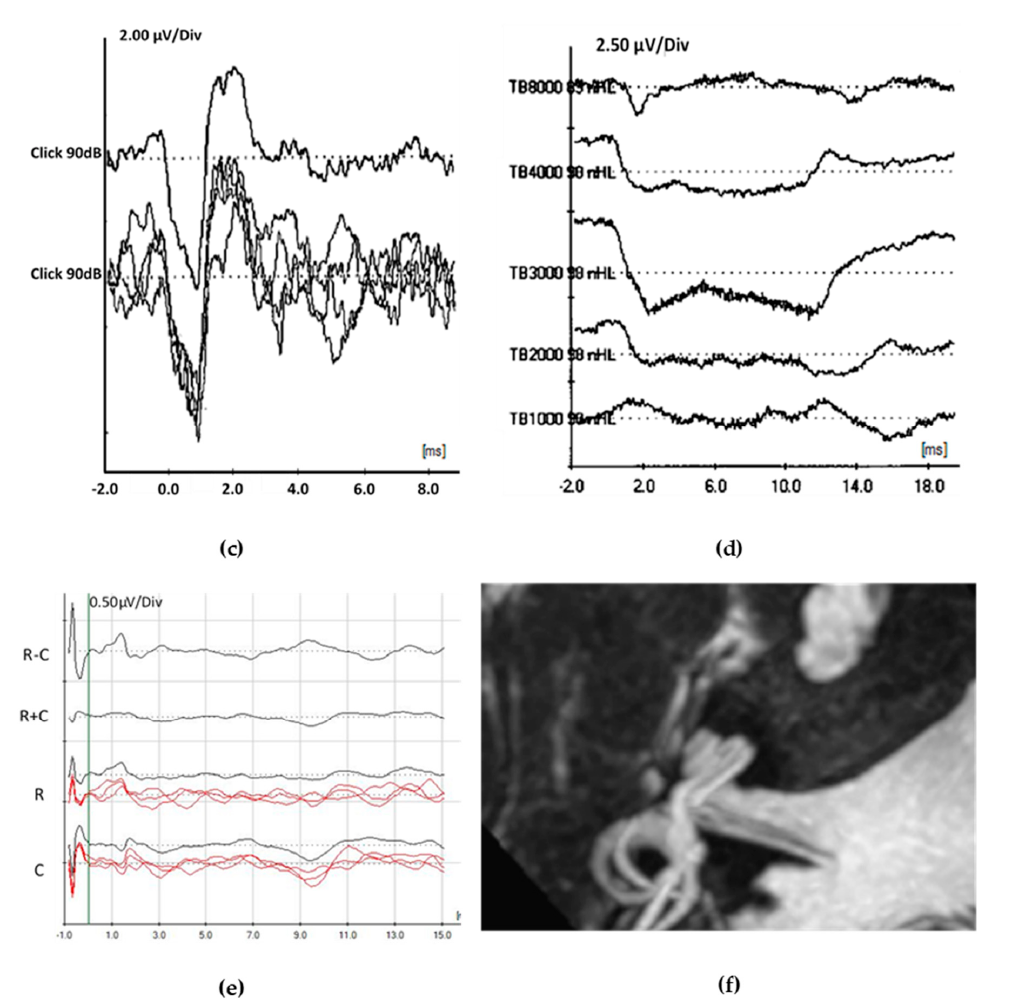
Figure 6. Audiological assessment in adult with acquired auditory neuropathy spectrum disorder (ANSD) caused by bilateral cochlear nerve hypotrophia of unknown etiology. Unaided pure tone (( a ), black line for right ear, gray line for left ear) and speech (( b ), both ears in free field) thresholds are poor, with no improvement with hearing aids. Electrocochleography (ECochG) recorded after clicks at 90 dB and at a rate of 14.3 s (( c ), grand average, above; superimposed, below) shows preserved summating potential (SP) and compound action potential (CAP). ECochG responses to tone-burst stimuli at di ff erent frequencies (( d ), grand averages for 8, 4, 3, 2 and 1 kHz) show a large SP. Auditory brainstem responses (ABRs) are absent, except for the cochlear microphonic (CM) ( e ). The 3-Tesla magnetic